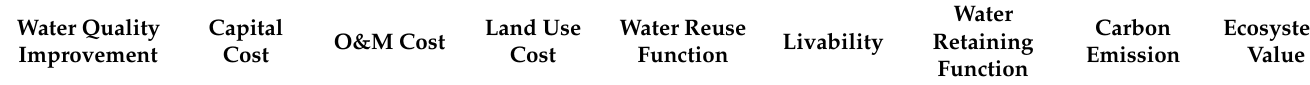
Table A8. Relative importance questionnaire of 10